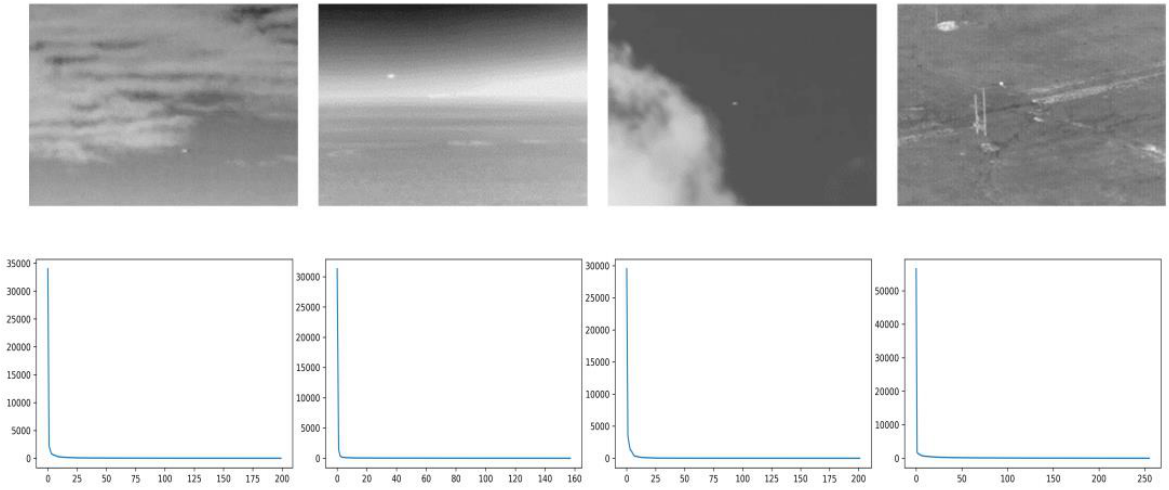
Figure 1. Infrared image and its corresponding singular value curve.